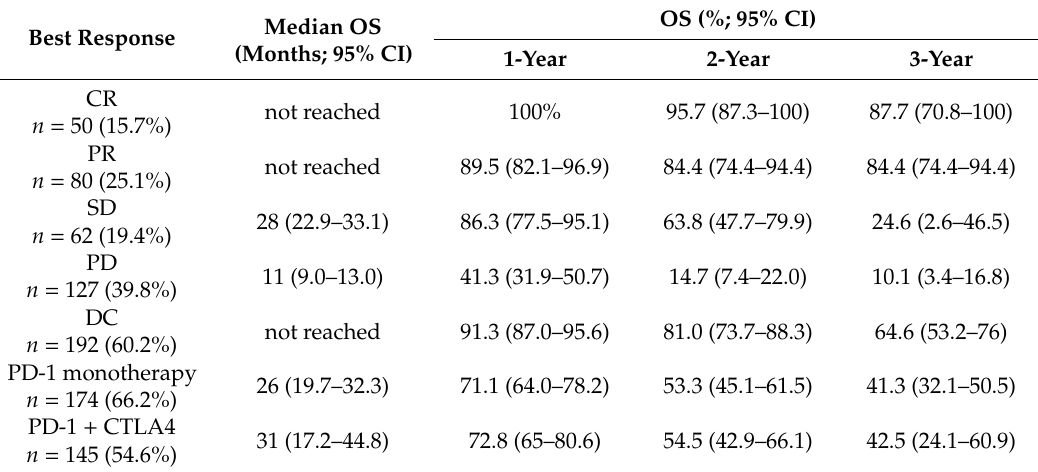
Table 2. Median overall survival and overall survival rates for patients receiving first-line PD-1-based immunotherapy according to best overall response and type of